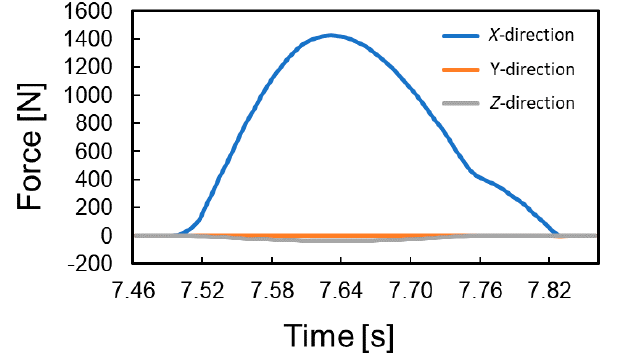
Figure 5. Time history of the force applied to the swimmer receives from the